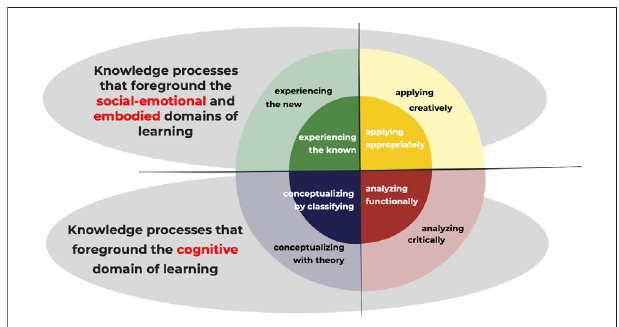
FIGURE 8 | Socio-material and cognitive orientations to